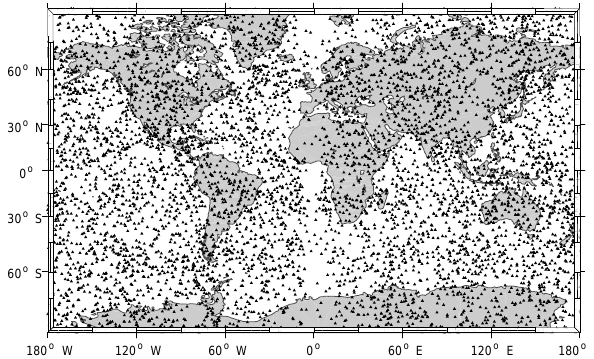
Figure 1. Fengyun-3C radio occultation point distribution from 1 to 30 September